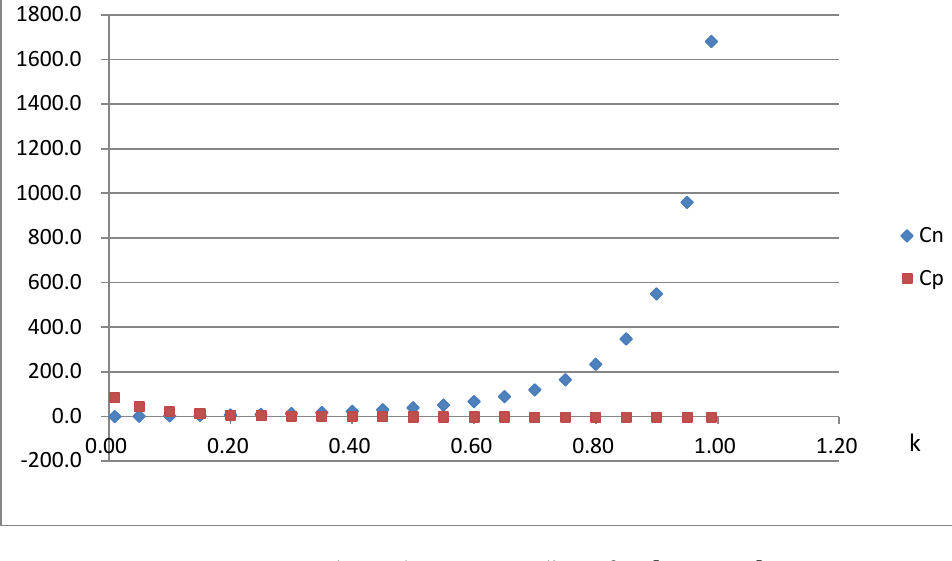
Fig. 3. Cp and Cn values corresponding to k ∈ [0.01,